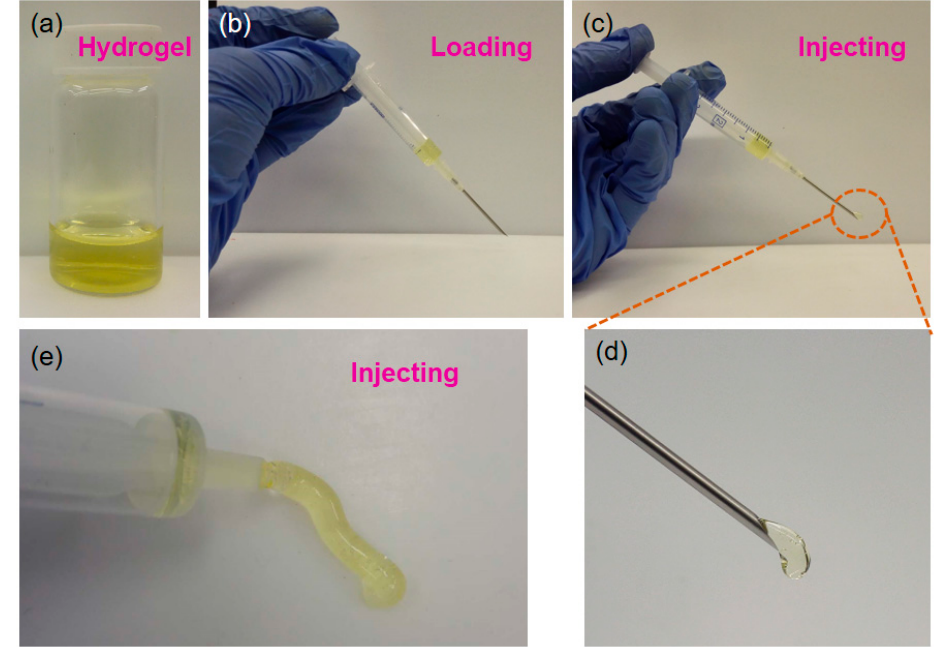
Figure 6. ( a – e ) The injectable characterization of supramolecular hydrogel.